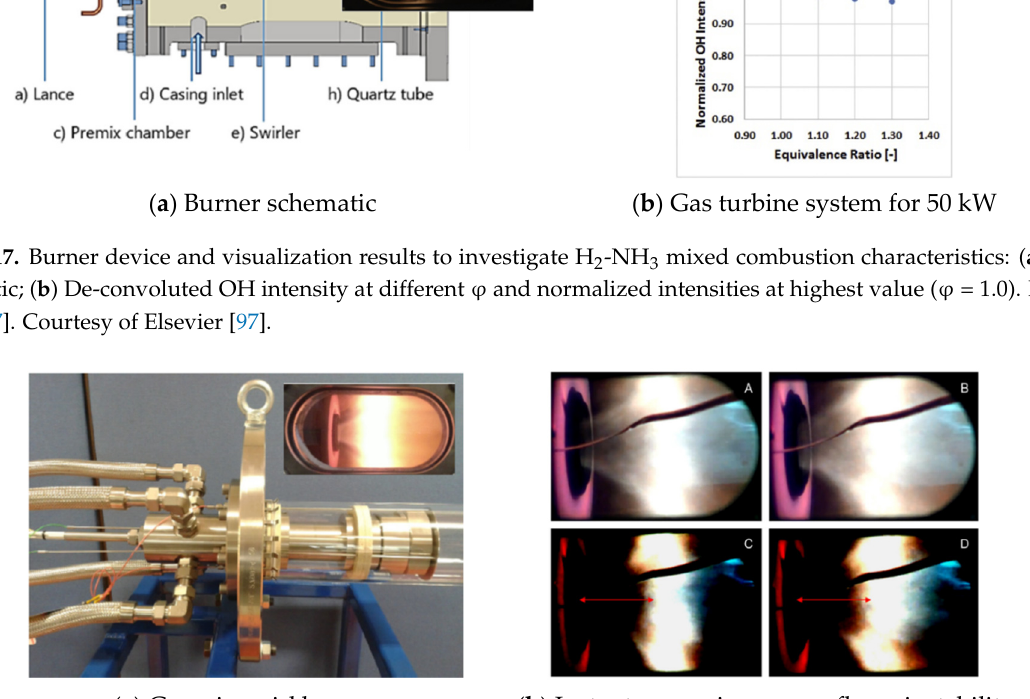
Figure 18. Gas turbine model combustor and direct images on NH 3 -CH 4 flames of 61% NH 3 and 39% CH 4 : ( a ) Gas turbine model combustor with NH 3 -CH 4 blend flame at equivalence ratio 1.31 for 31.7 kW; ( b ) Instantaneous photographs on flame position change (instability) . Modified from [98]. Courtesy of Elsevier [98].